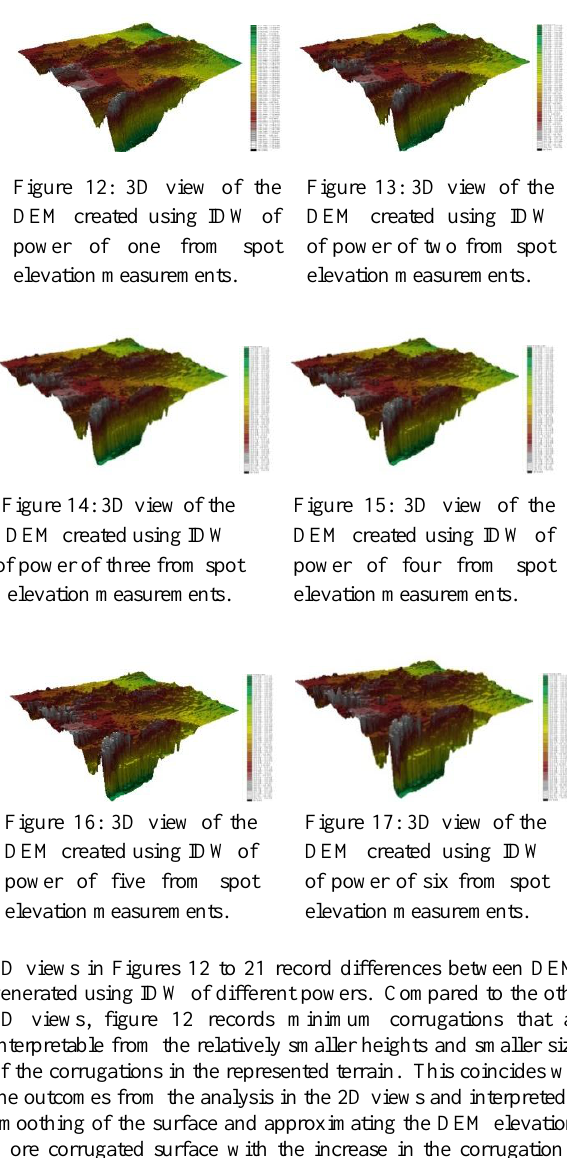
Figure 16: 3D view of the DEM created using IDW of power of five from spot elevation